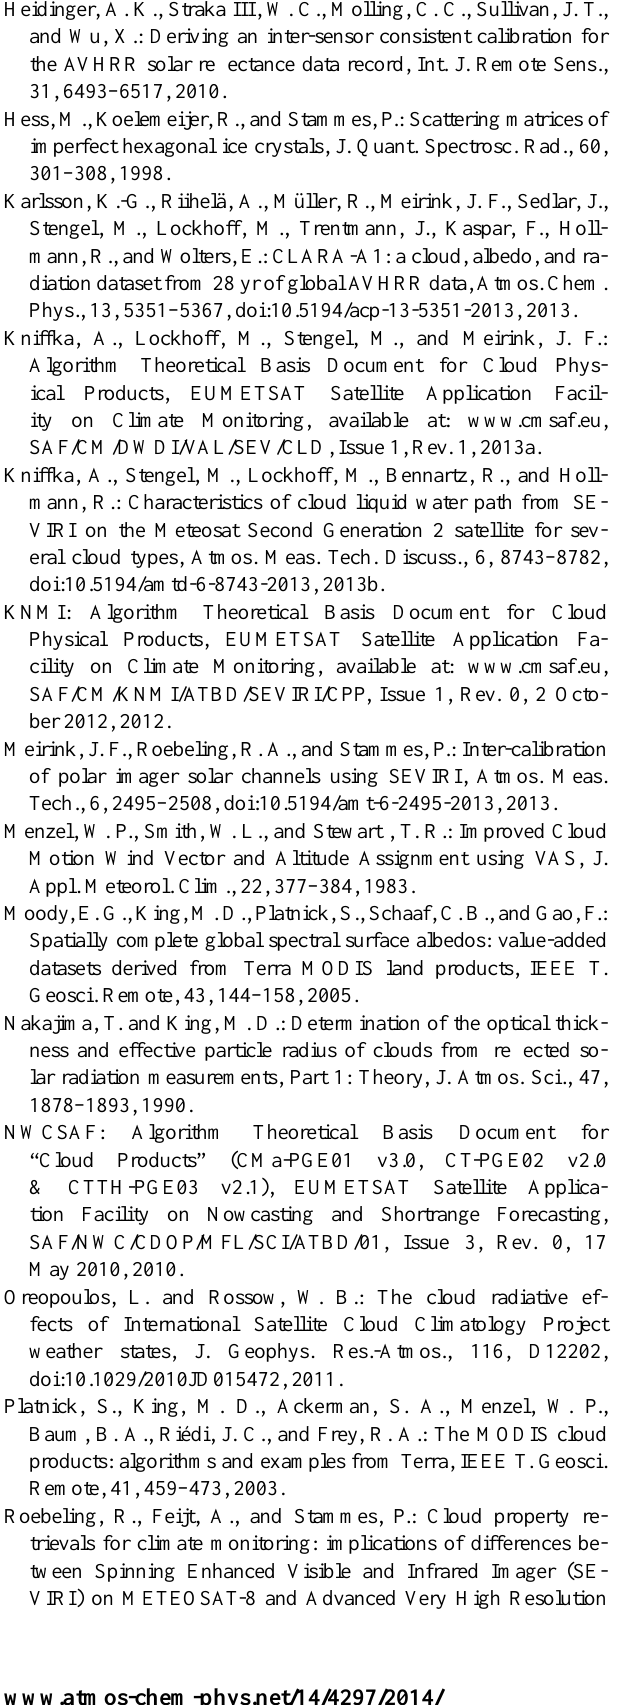
Algorithm Theoretical Basis Document for Cloud